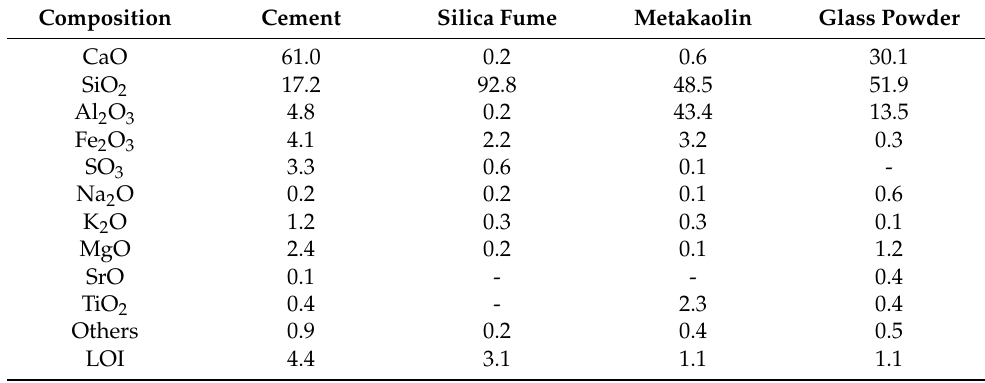
Table 1. Oxide compositions of raw materials obtained by X-ray fluorescence analysis.